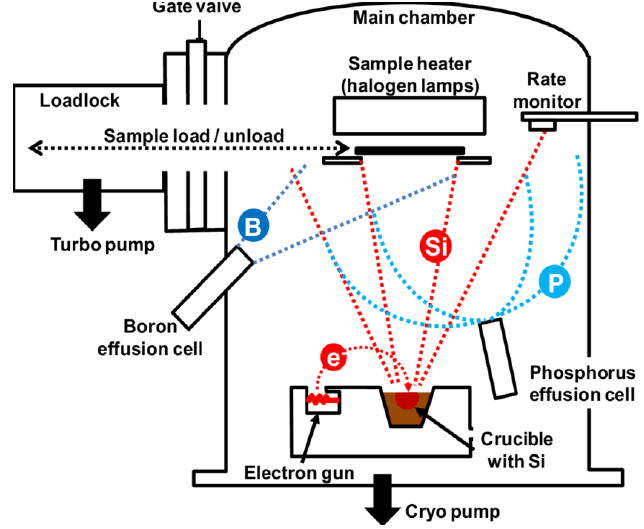
Figure 1. Scheme of the electron beam evaporation set.